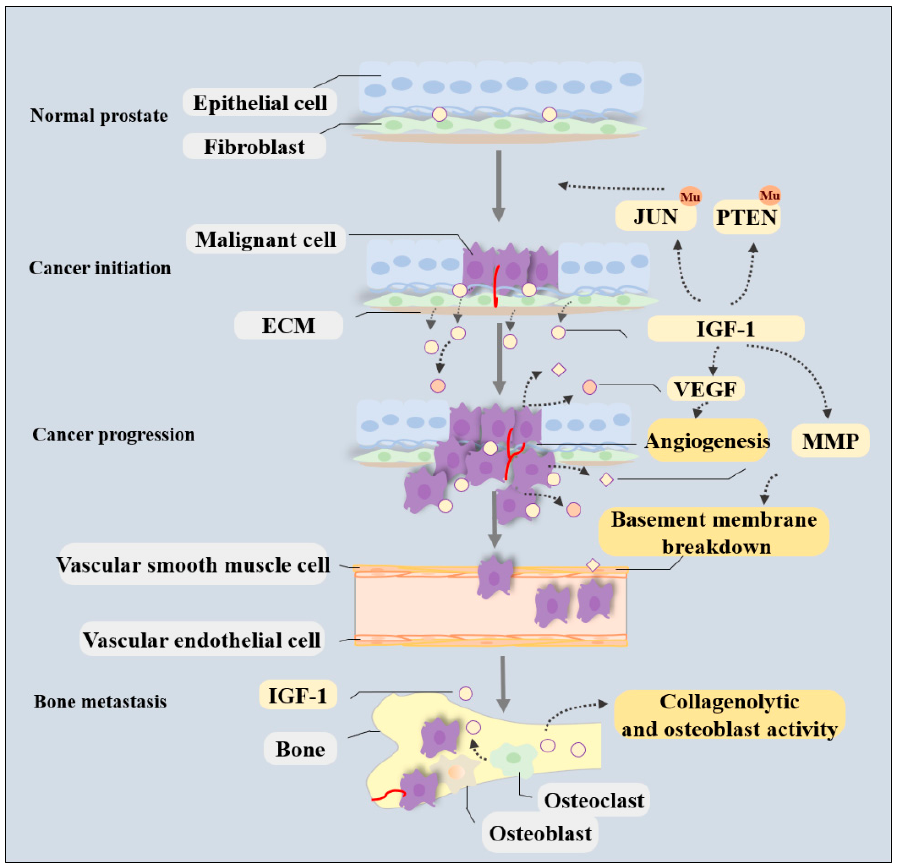
Figure 1. Schematic representation of the IGF-1 signaling on promoting PCa development in tumor niche. Autocrine and paracrine IGF-1 signaling from the malignant cells, fibroblast, and ECM can contribute to tumor growth and distant metastasis in PCa. IGF-1 can induce by regulating the mutation of oncogenes and tumor suppressor genes. It can induce angiogenesis in the tumor microenvironment by enhancing VEGF expression and promoting degradation of ECM components by stimulating MMP release to favor metastasis of cancer cells. In addition, IGF-1 produced by the bone matrix can increase the collagenolytic and osteoblast activity of neoplastic cells, thus contributing to bone metastasis